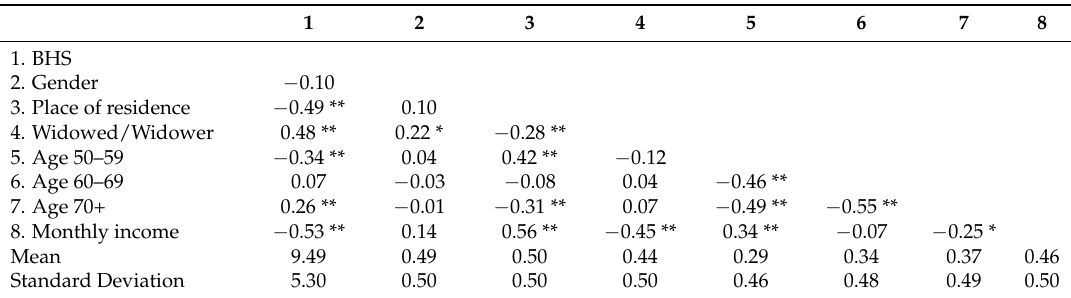
Table 3. The correlations among the study variables.